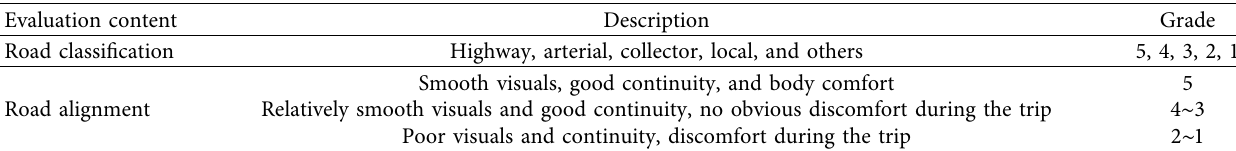
Table 3: Road design attribute index and grading